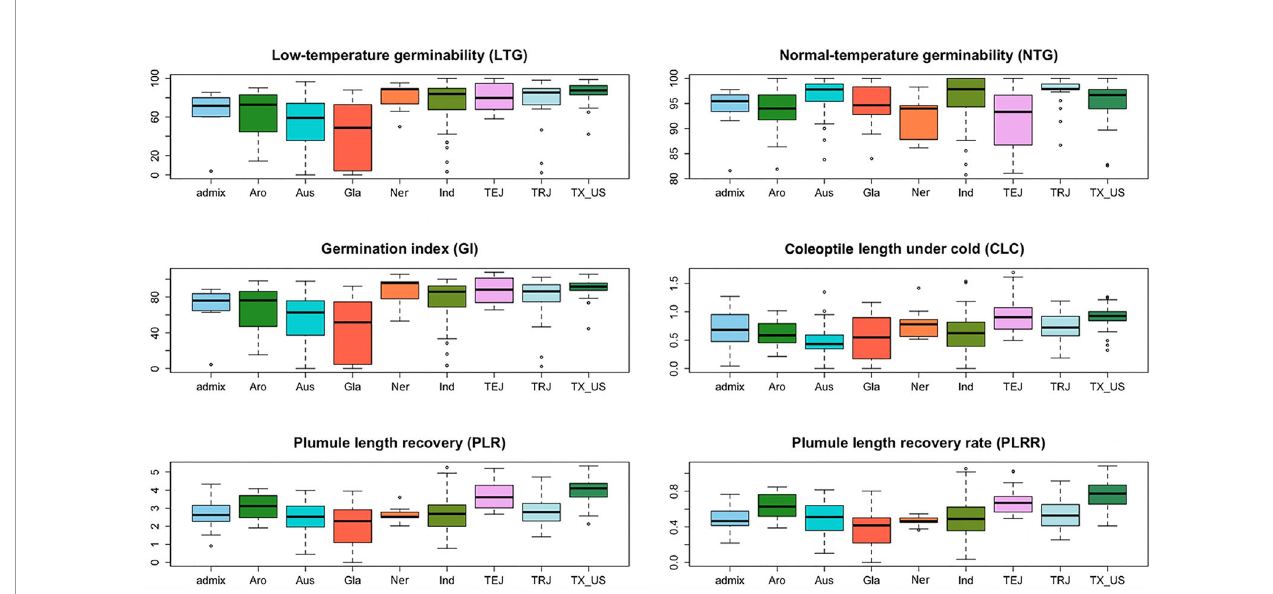
FIGURE 1 | The box plots from all sub-populations identi fi ed by the STRUCTURE software presented for all the traits measured: low-temperature germinability (LTG), percentage germination under normal condition (NTG), germination index (GI), coleoptile length under cold (CLC), plumule length recovery (PLR), and plumule length recovery rate (PLRR).